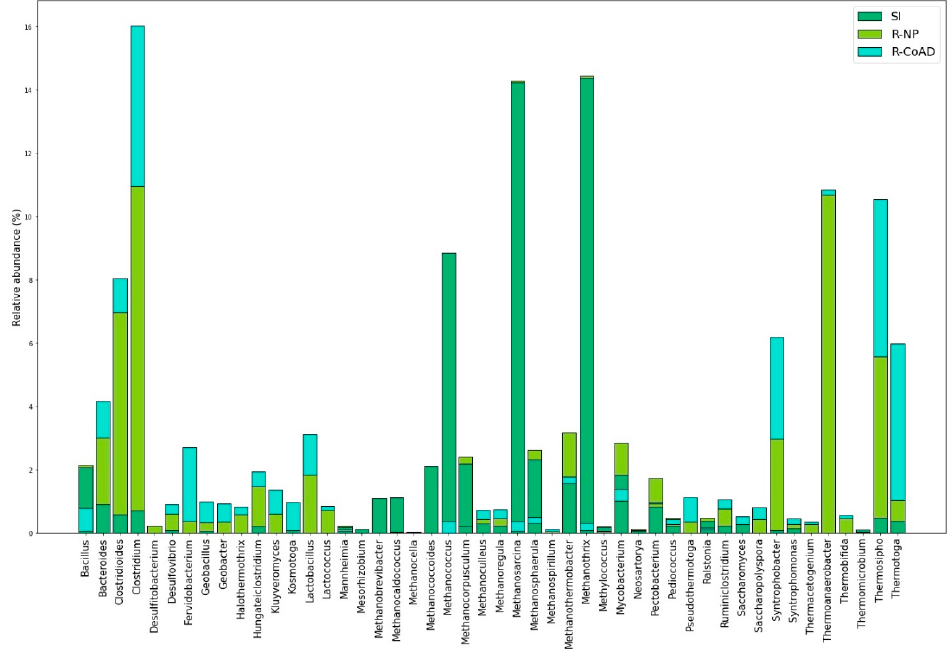
Figure 3. Relative abundance and distribution of identified proteins assigned to bacterial and archaea in each sample. Average of triplicates. SI: seed inoculum, R-NP: Nanoparticle’s reactor, R-CoAD: Co-digestion reactor.